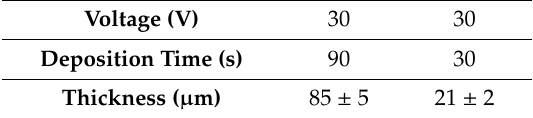
Table 3. Thickness values of the two optimal 45S5 Bioglass ®